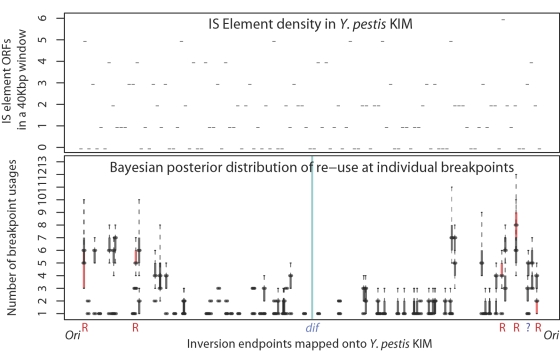
Hotspots of breakpoint re-use in Yersinia exist near the origin.Top: Number of annotated IS element ORFs in non-overlapping 40 Kbp windows of the Y. pestis KIM genome. Bottom: Hotspots of breakpoint re-use in Yersinia. The 78 blocks have 156 endpoints. Posterior estimates of the number of times each endpoint has been used are plotted here, with block endpoints positioned according their location in the Y. pestis KIM genome. Endpoints within 1500 bp of a ribosomal operon in at least one of the eight genomes are colored red and marked by ‘R’, while endpoint regions containing an annotated IS element are colored black. Only one breakpoint region is free from IS elements and ribosomal genes in all genomes, as marked by ‘?’. Together, the top and bottom panels demonstrate that we rarely observe inversions with endpoints proximal to the terminus in Yersinia, despite the presence of numerous IS elements in that region.